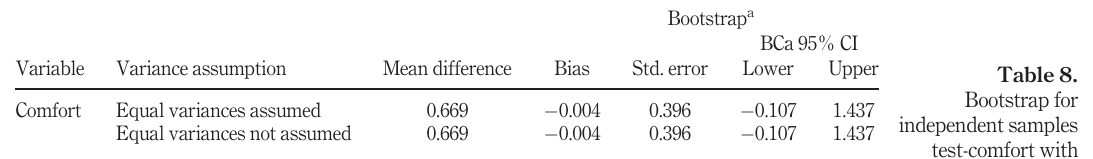
independent samples test-comfort